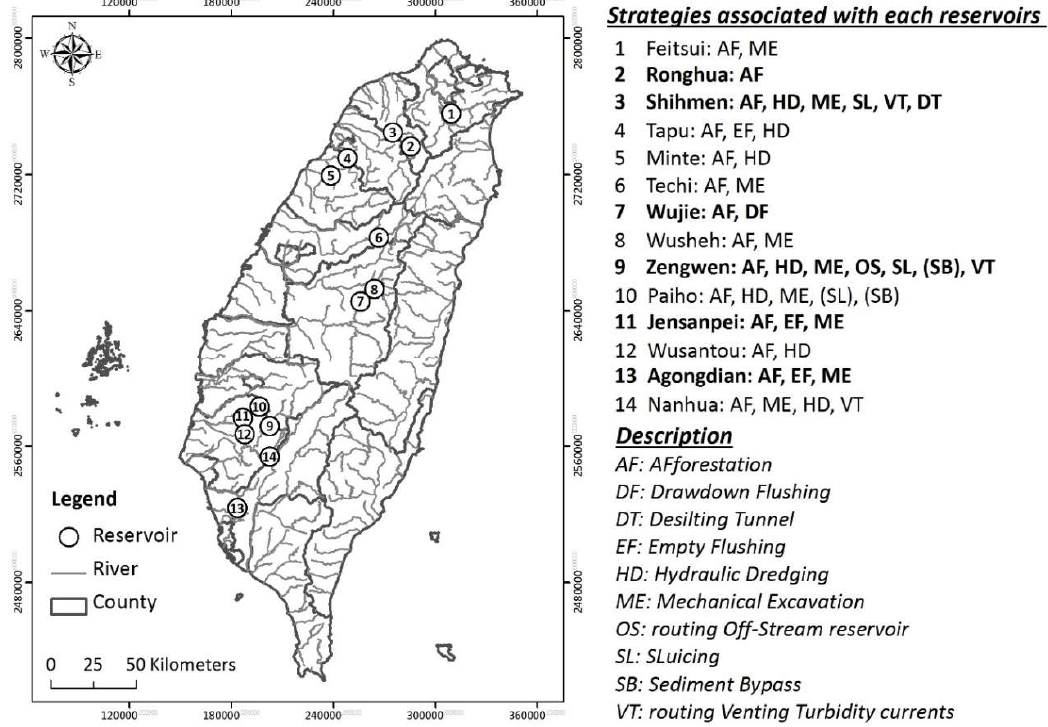
Figure 1. Locations of some of the reservoirs in Taiwan and strategies associated with each reservoir. Those highlighted in bold are the case study sites (data courtesy of WRA, Taipower Company, Taiwan Sugar Corporation, and Taiwan Water Corporation).